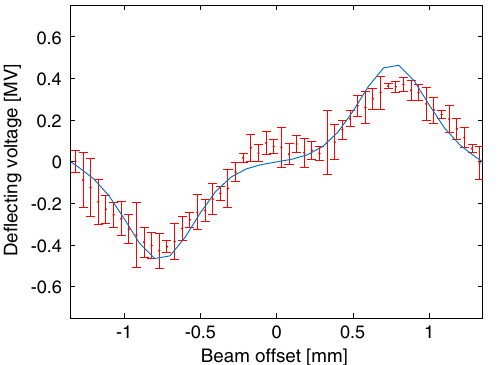
FIG. 5. Measurement of beam deflection in a horizontal scan with gap ¼ 0 . 9 mm. The blue line is the